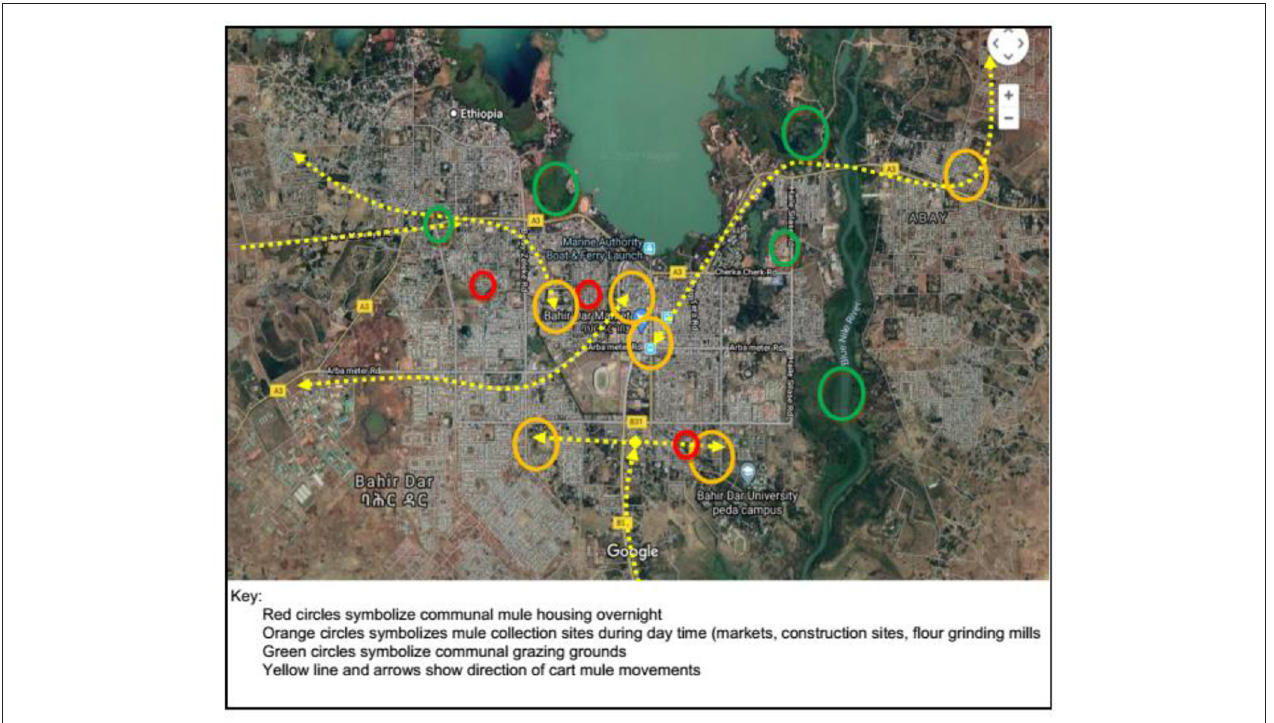
FIGURE 5 | Cart mule movement dynamics and gathering sites in Bahir Dar.